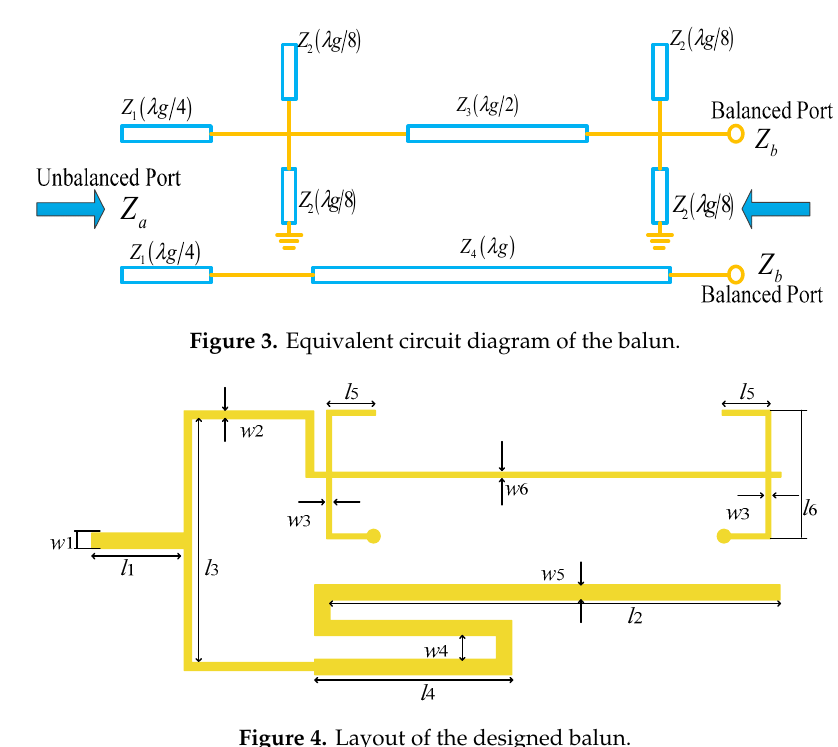
Figure 4. Layout of the designed balun. Table 1. Physical dimensions of the designed balun.